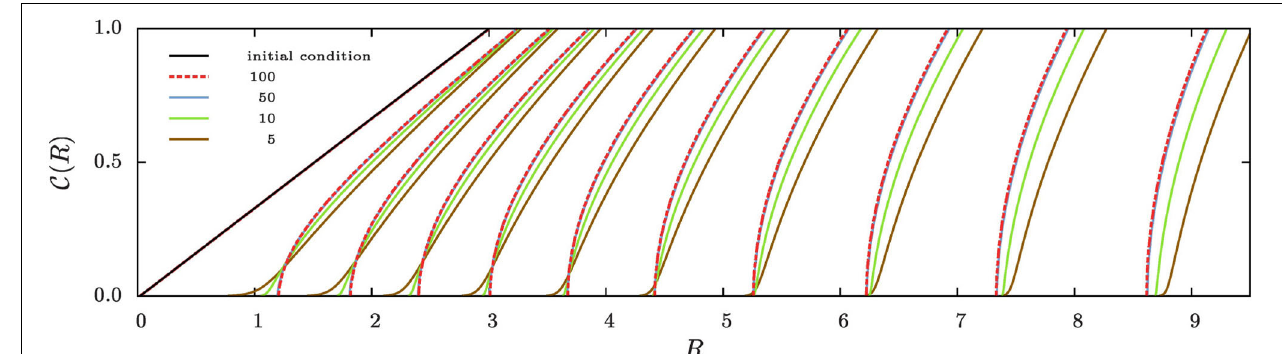
FIGURE 3 | The four sets of curves of different color show stroboscopic snapshots of the time evolution of the cumulative size distribution function, C ( R ) , of aggregates for the same initial condition, and k = 5, 10, 50, and 100, respectively. Here and in the following we use dashed lines for the largest value of k displayed in the plot, and solid lines for all other curves. We use the same color for all data referring to a given value of k , and provide the initial conditions, Equation (7b), by a solid black line (the leftmost